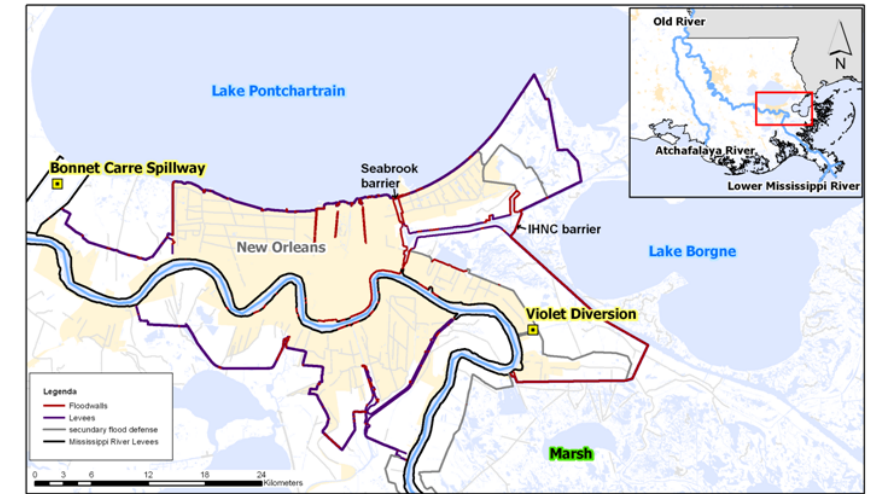
Figure 2. Upgraded flood protection for New Orleans and